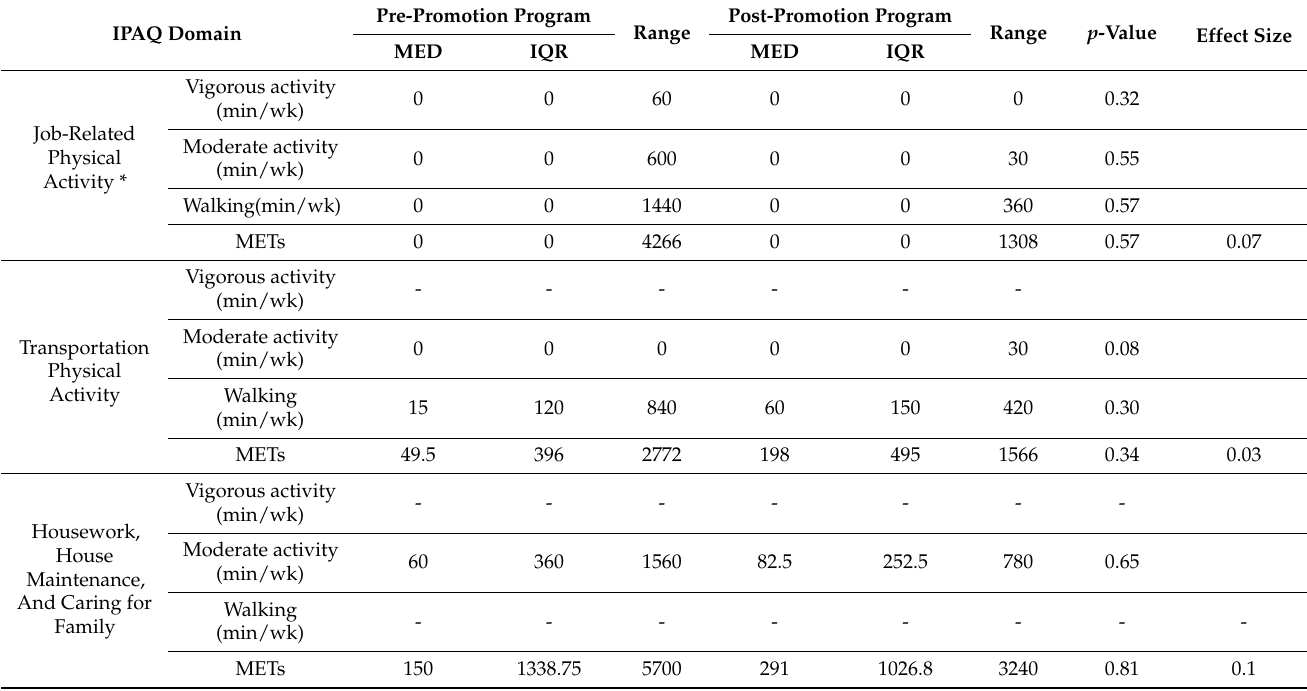
Table 1. International Physical Activity Questionnaire (IPQA-LF) changes following the Tele-Physical Activity promotion